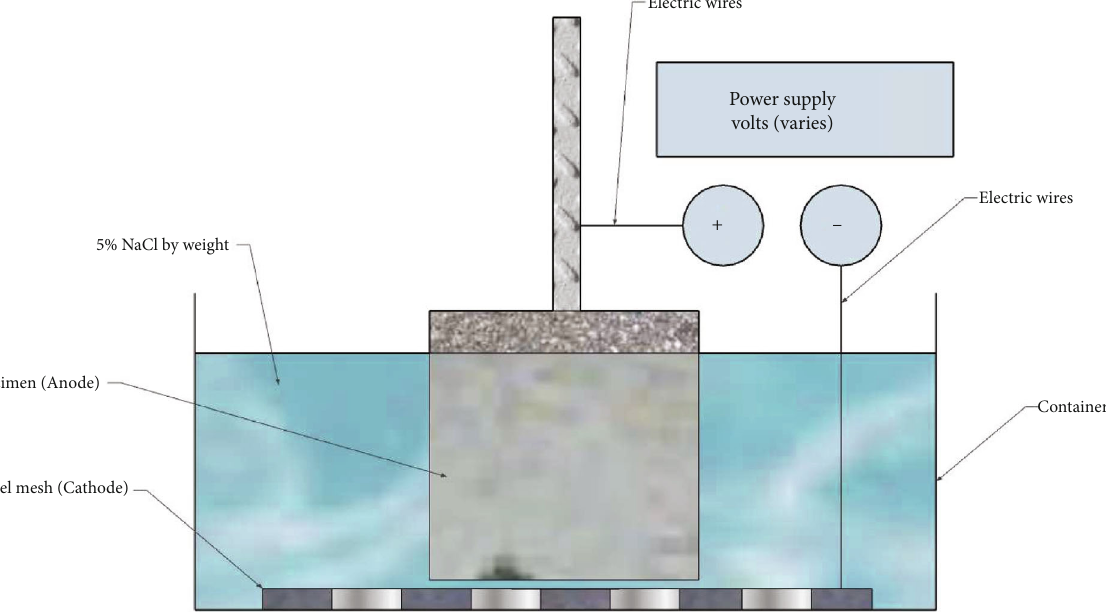
Figure 7: Illustrations of accelerating corrosion of specimens.